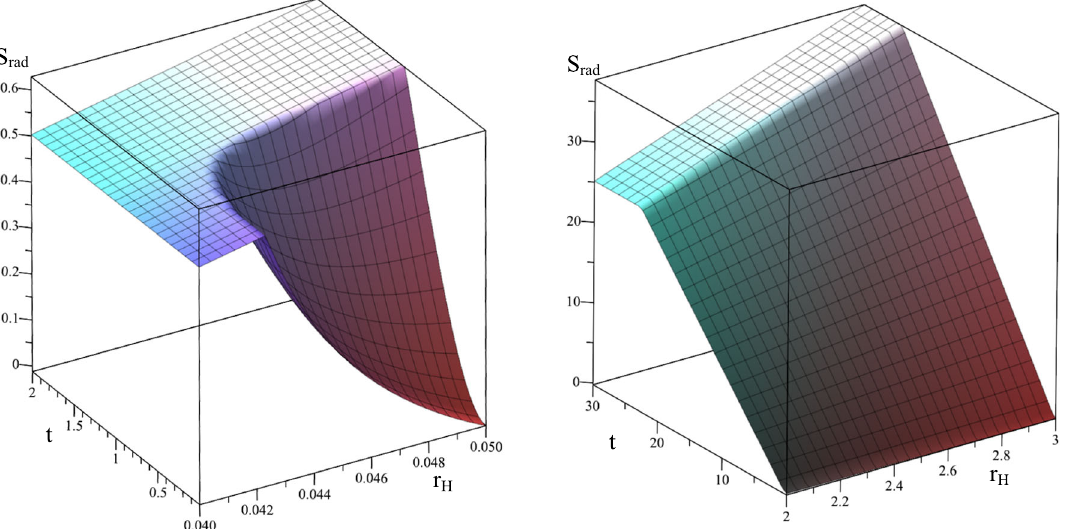
Fig. 8 Page curves for different black holes with c = 1 . 5. a Page curves as a function of time t and radius r H for a series of the small black hole at Q 2 = 0 . 04. b Page curves as a function of time t and radius r H for the large black hole at Q 2 = 0 .